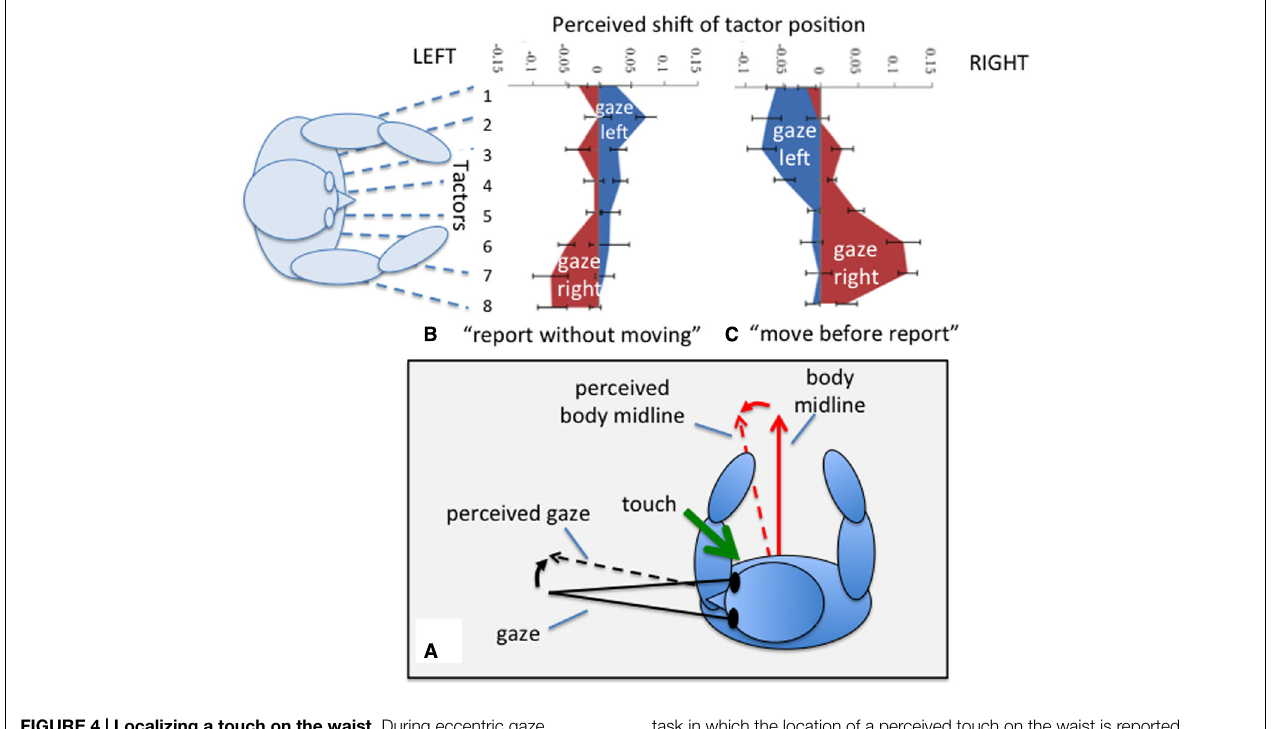
task in which the location of a perceived touch on the waist is reported without moving gaze, left gaze is associated with a shift (blue area) toward the right and vice versa (B) . If participants shift gaze before reporting, displacements are in the direction of gaze (C) . Data redrawn from Pritchett et al. (2012).